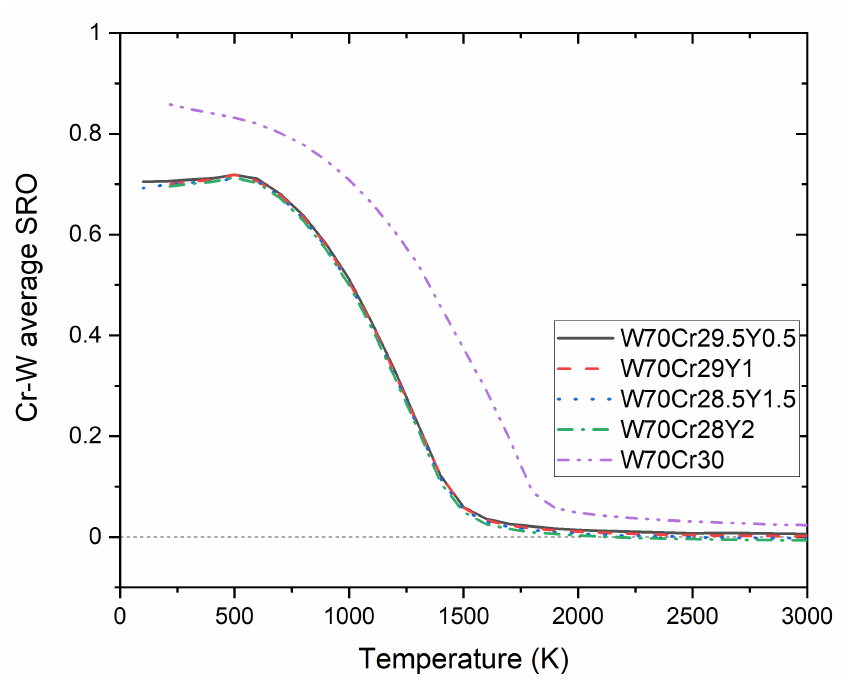
Figure 8. Cr-W average SRO comparison between W 70 Cr 30 and derivative W 70 Cr ( 30 − x ) Y x , for x = ( 0.5;1;1.5;2 )